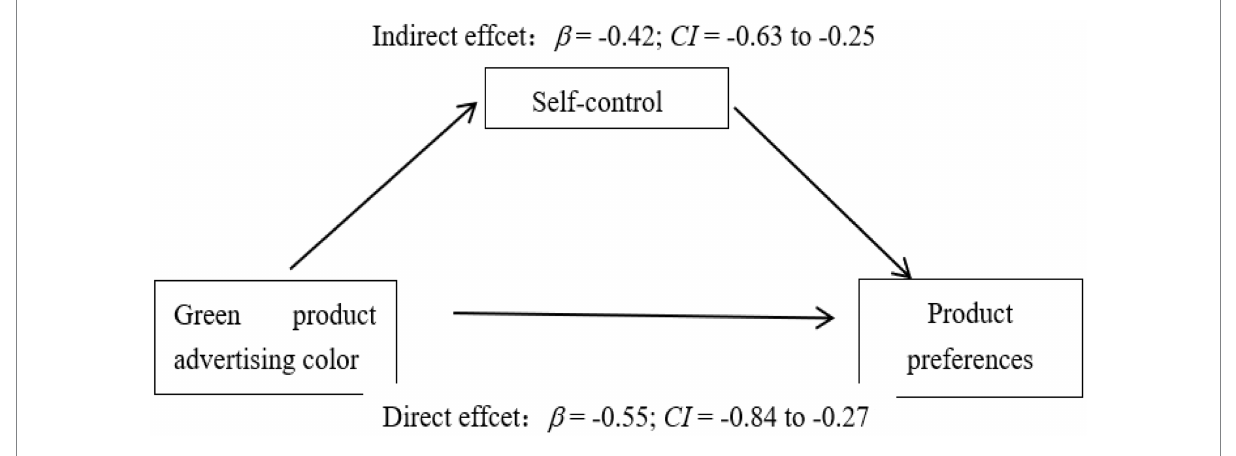
FIGURE 1 The Mediating effect of Self-control System.